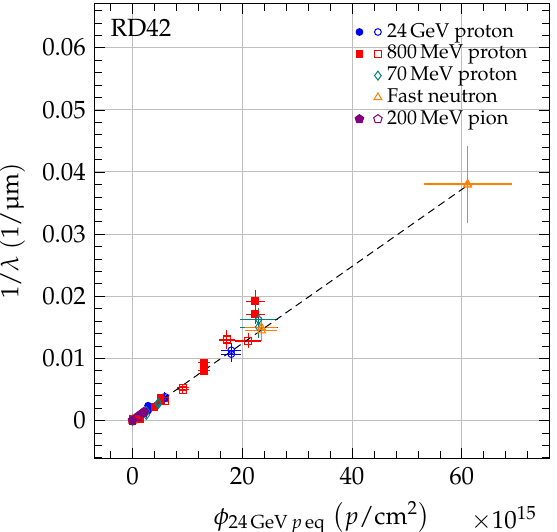
Figure 10. The 1/ λ for scCVD (solid markers) and pCVD (open markers) diamond. Each point is shifted by 1/ λ 0, j . The fluence of each point was scaled by the relative damage constant, κ i , to the 24GeV proton equivalent fluence. The damage model (dashed line) is fitted to the data